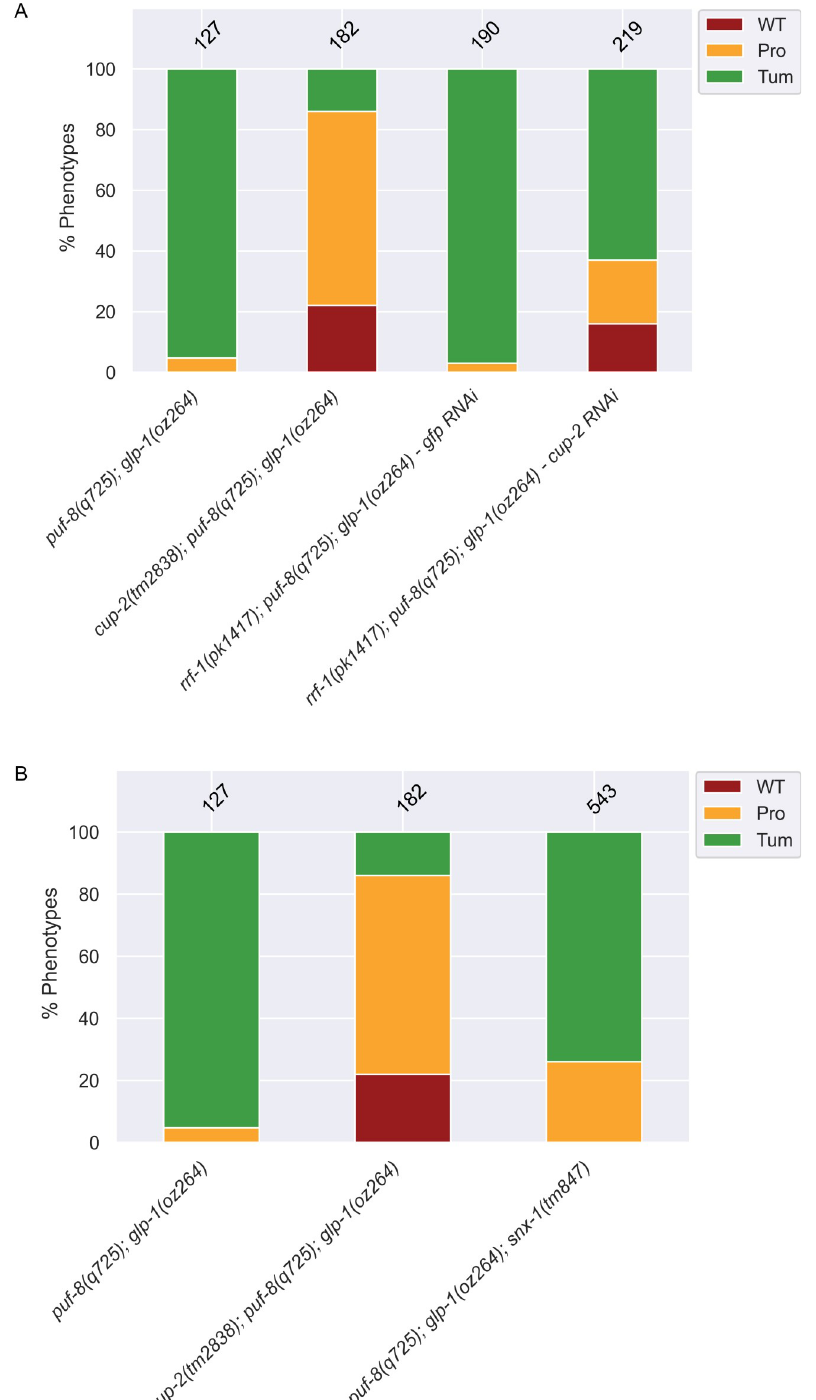
Fig 6. Retrograde transport may contribute to cup-2 activity and cup-2 is required mainly within the germline to promote germ cell proliferation. A. Quantification of phenotypic analysis of the effect of loss of snx-1 , cup-2 ’s partner in retrograde transport, on suppression of puf-8(q725); glp-1(oz264) tumours. Phenotypes were analyzed by α -REC-8 and α -HIM-3 immunostaining. B. Quantification of phenotypic analysis of the effect of knockdown of cup-2 activity within the germline by using a rrf-1(pk1417) mutant background which largely restricts RNAi efficacy to the germline. cup-2 RNAi and gfp RNAi was performed by injection of dsRNA. puf-8(q725); glp-1(oz264) and cup-2(tm2838);